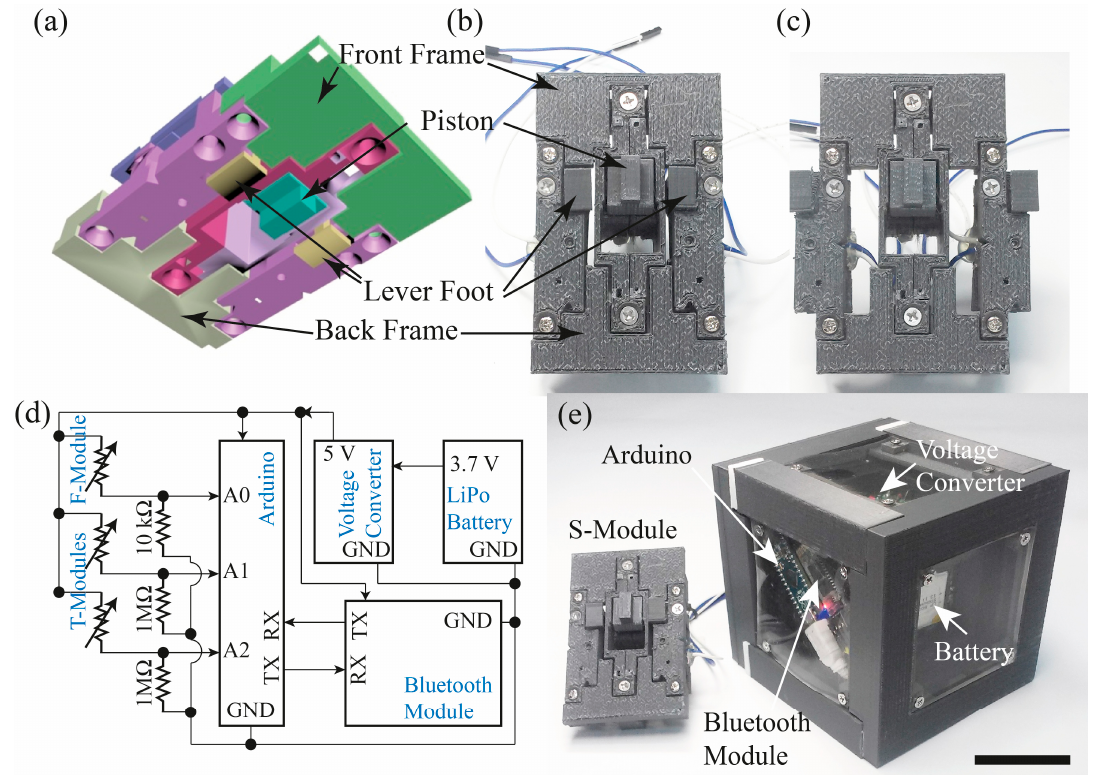
Figure 6. Assembly of the portable stiffness measurement system. ( a ) 3-dimensional schematic illustration of the assembled s-module. ( b ) A picture of the assembled s-module, and ( c ) the same module with interchanged t-module placements. ( d ) A circuit diagram of the stiffness measurement system. ( e ) A picture of the completed system. The scale bar represents 5 cm.